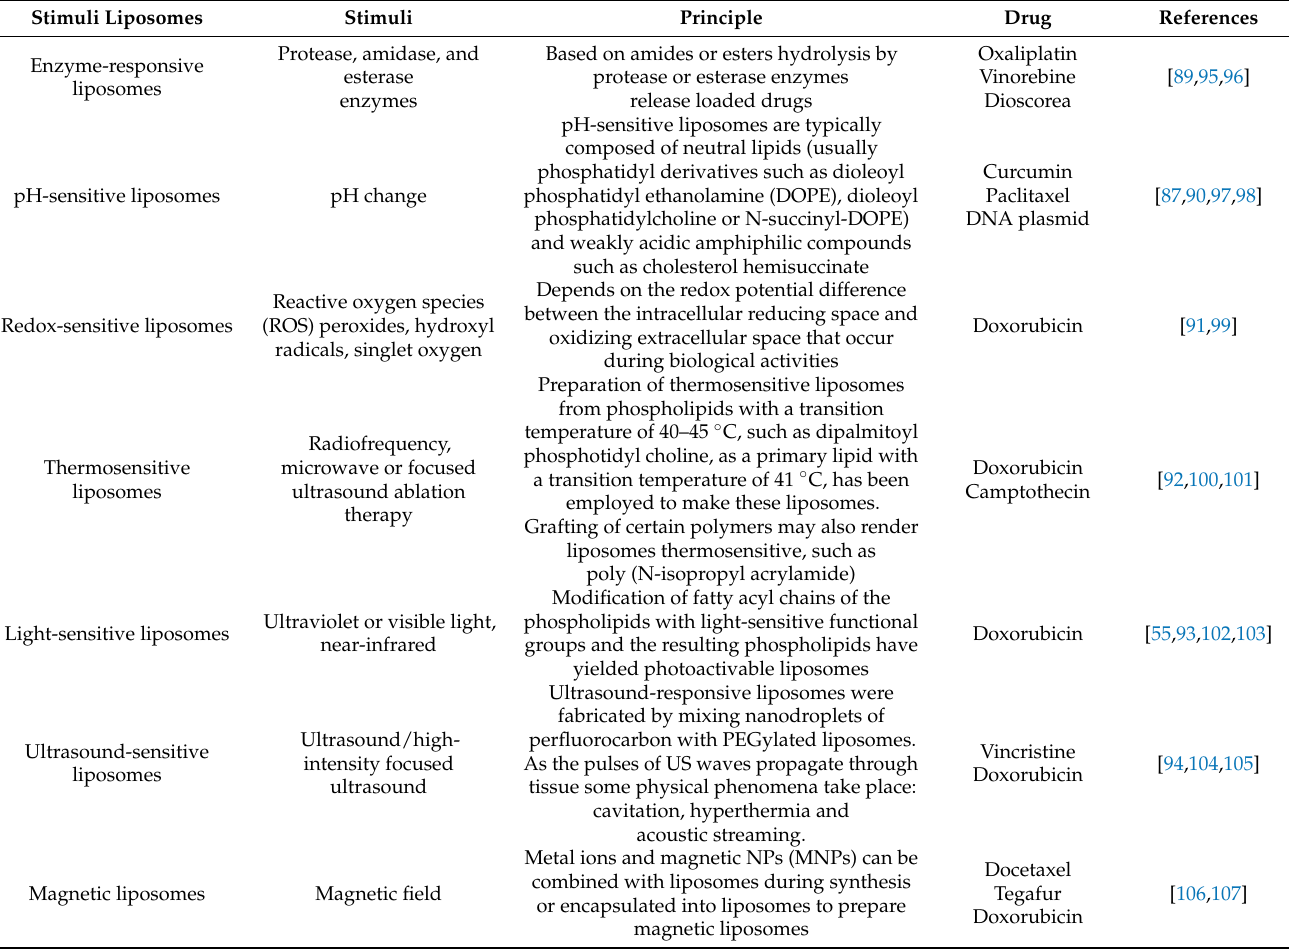
Table 3. The most common stimuli-responsive